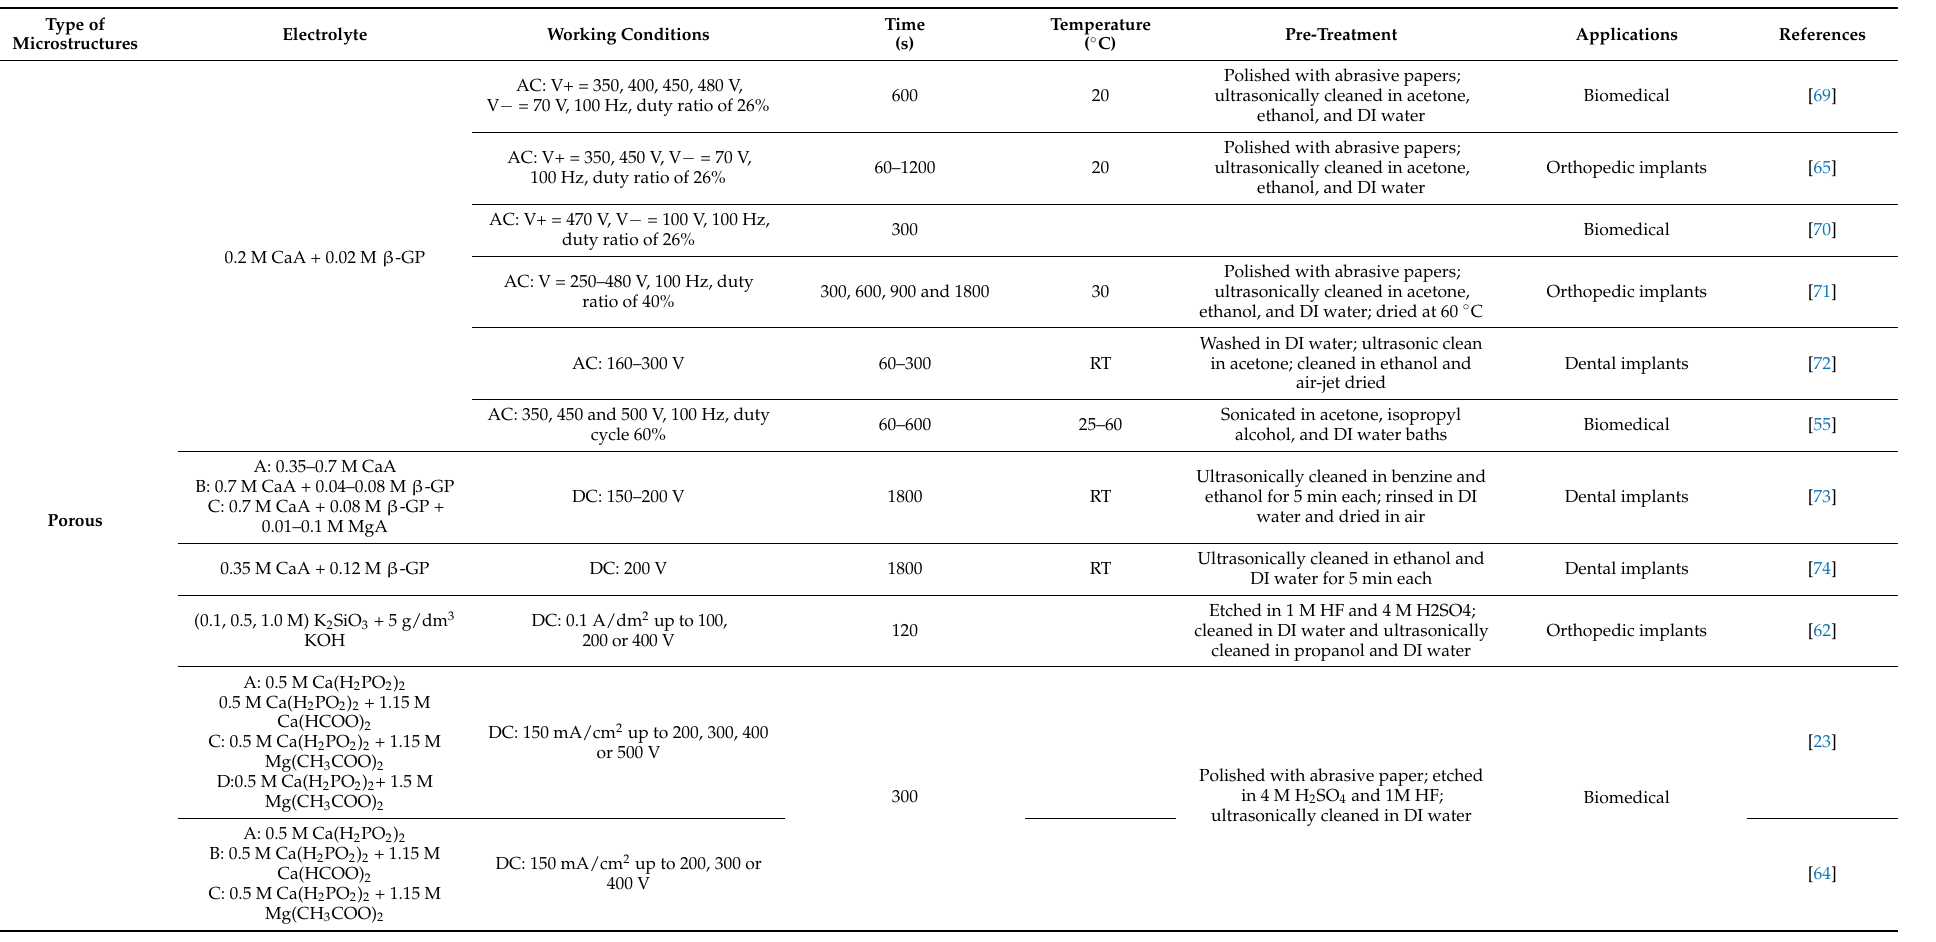
Table 1. Review table of the different types of Ta nanostructures after MAO treatment under different